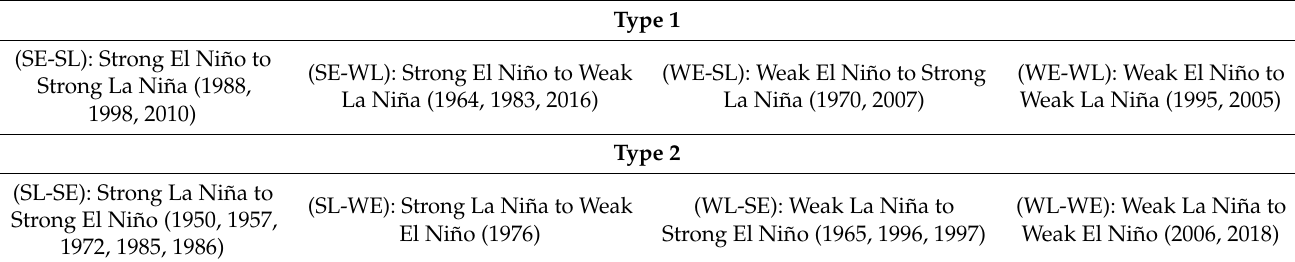
Table 1. Types, subtypes, and instances of type 1 and 2 ENSO transition years. Type